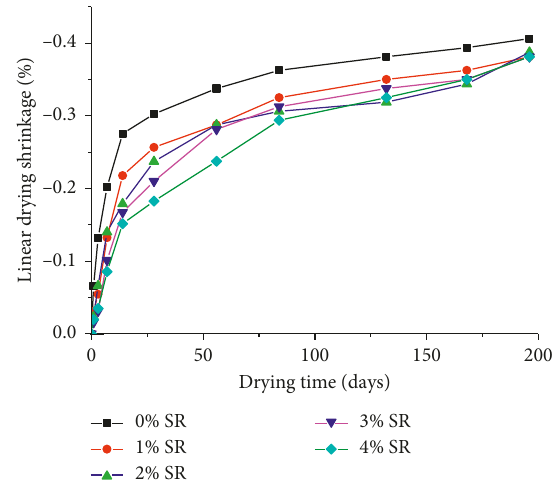
Figure 4: Autogenous deformation versus time for 200days for mortar mixtures with various SR contents.